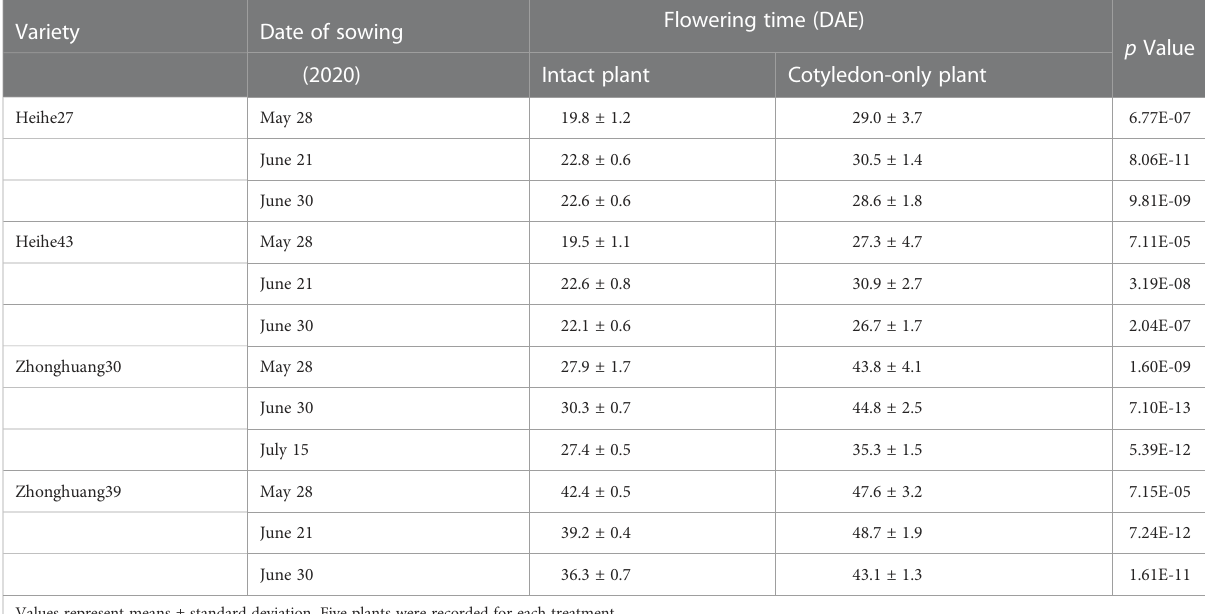
TABLE 1 The comparison of fl owering time of intact and cotyledon-only plant of early-maturing and middle-maturing varieties under natural day-length conditions.